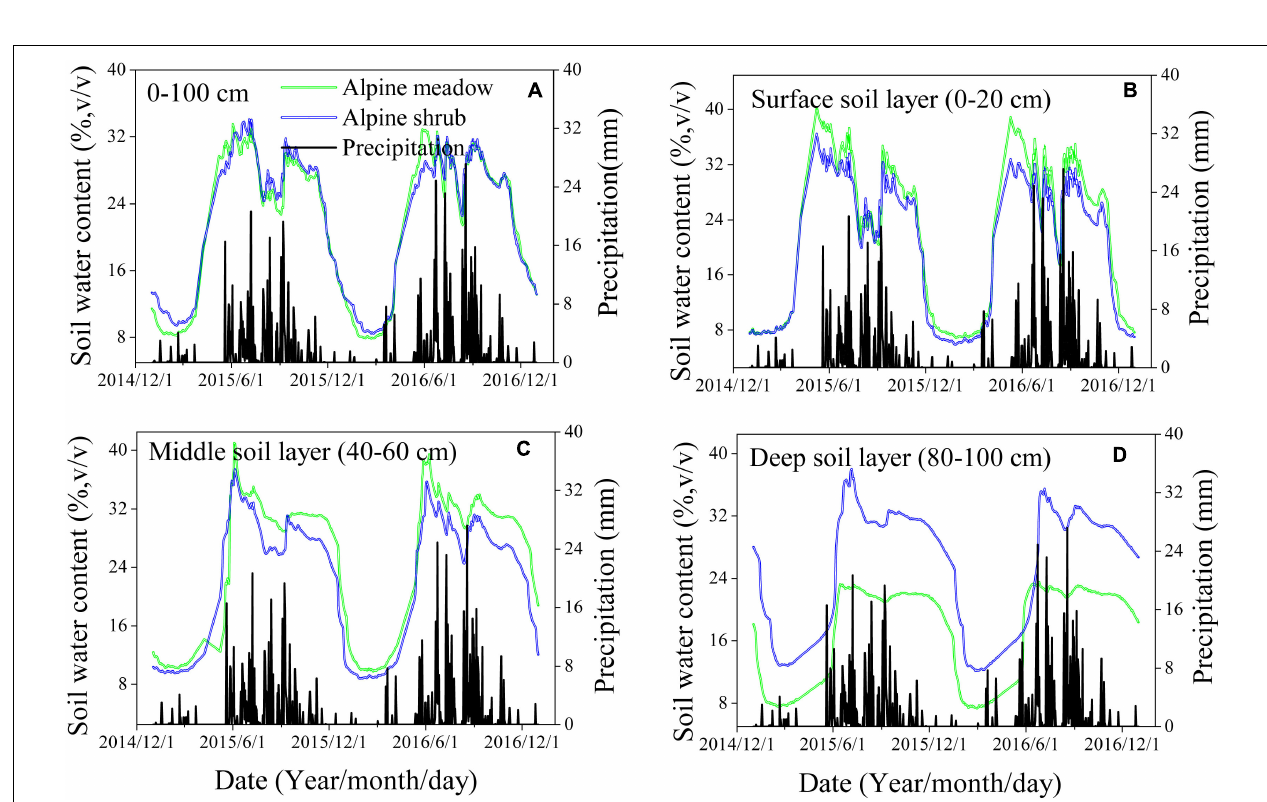
FIGURE 3 | Daily variations of soil water content for 0–100 cm (A) , surface soil layer (B) , middle soil layer (C) , and deep soil layer (D) across two vegetation types.